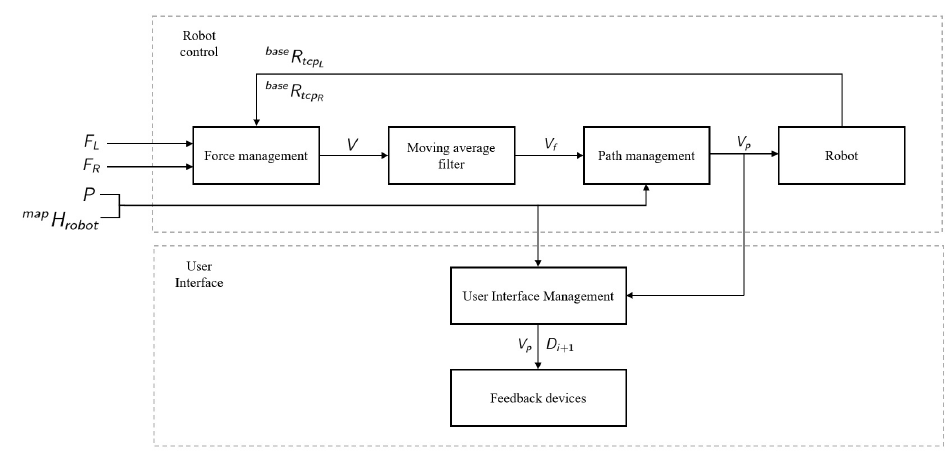
Figure 1. Proposed architecture for mobile part